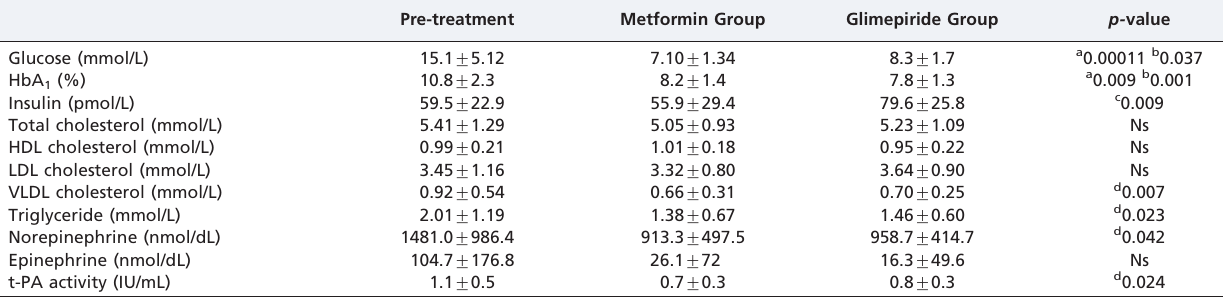
Table 2 - Glucose, glycated hemoglobin, insulin, total and fractional cholesterol, triglycerides and catecholamine levels.